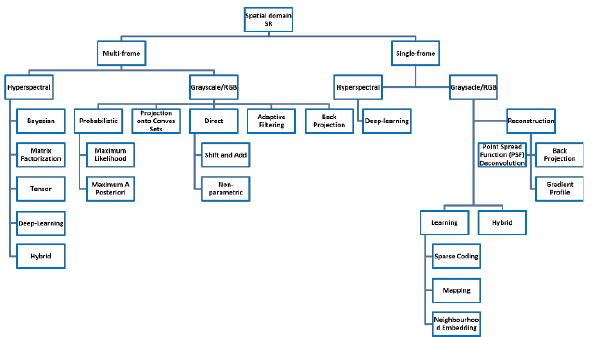
Figure 1. Functional Classification of Spatial Domain SR